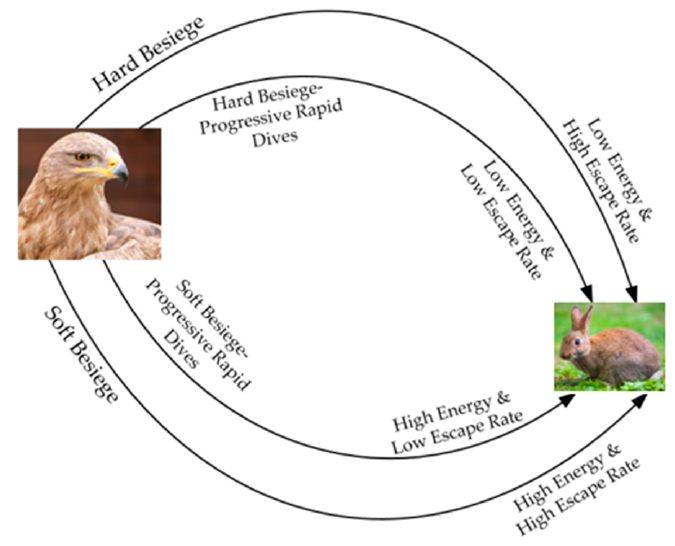
Figure 5. Predation patterns during exploitation of the HHO algorithm.